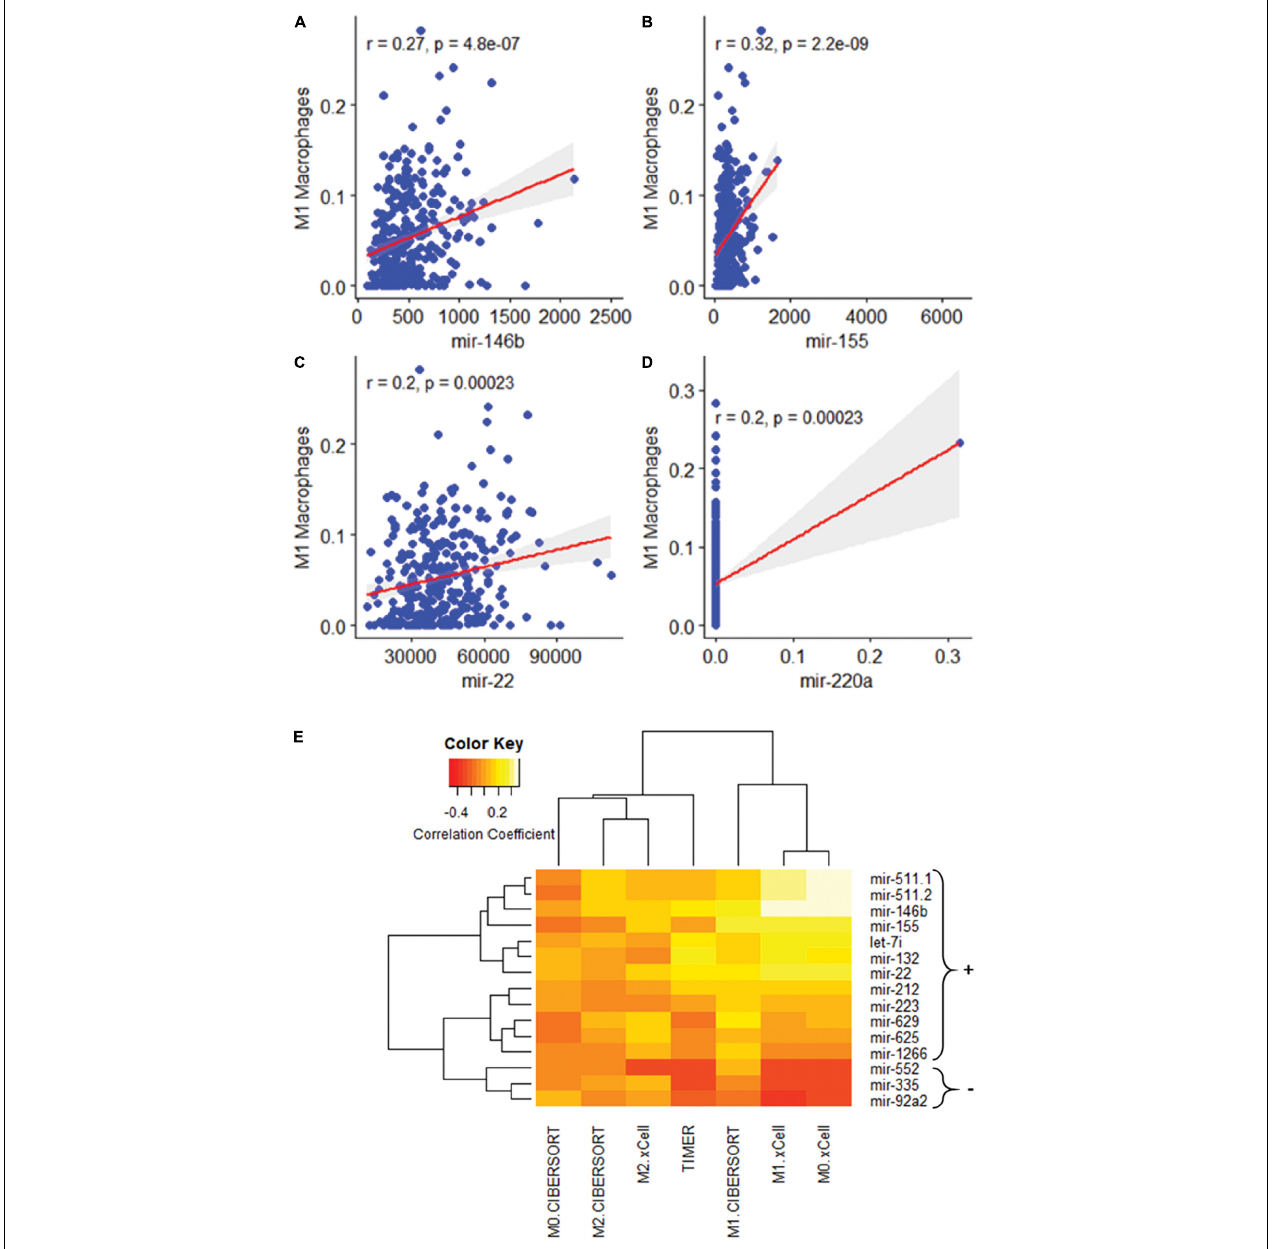
FIGURE 3 | Association of M1 macrophage polarization with miRNAs. (A–D) Association of M1 macrophage polarization with: mir-146b ( p = 0.00), mir-155 ( p = 0.00), and mir-22 ( p = 0.00). mir-220a was excluded as the correlation was the result of a single outlier. (E) A heatmap of 15 miRNA sequences correlated with macrophage